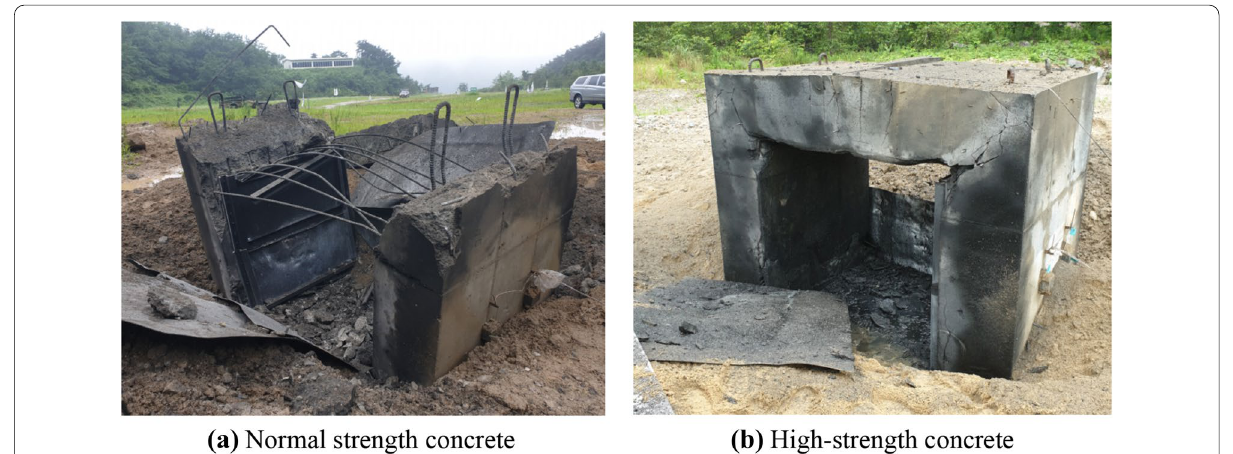
Fig. 13 Experimental structures after blast